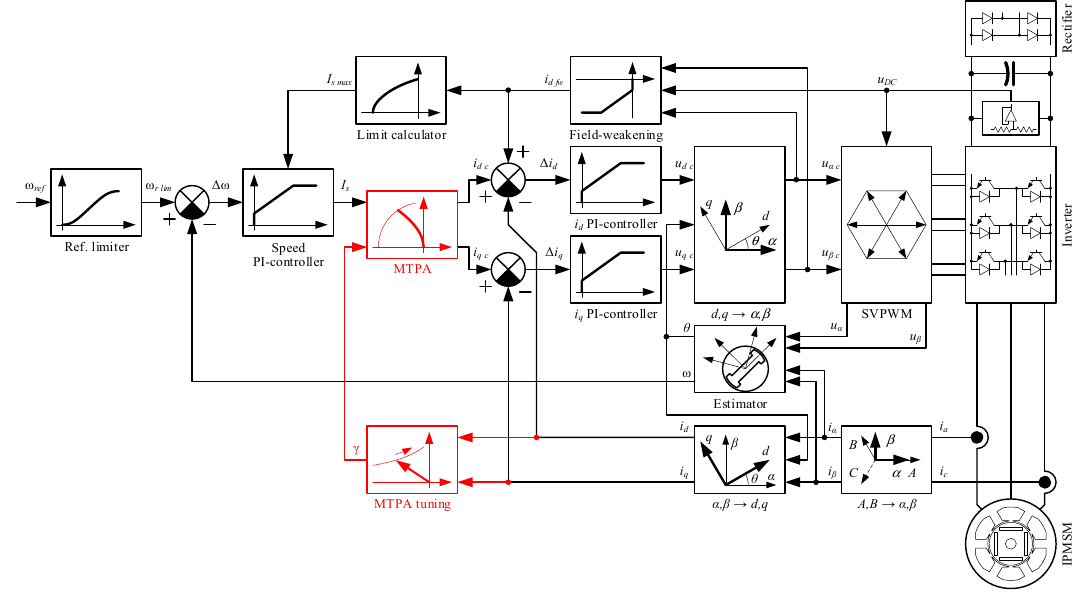
Figure 6. Structure of the sensorless control scheme of the IPM motor drive.